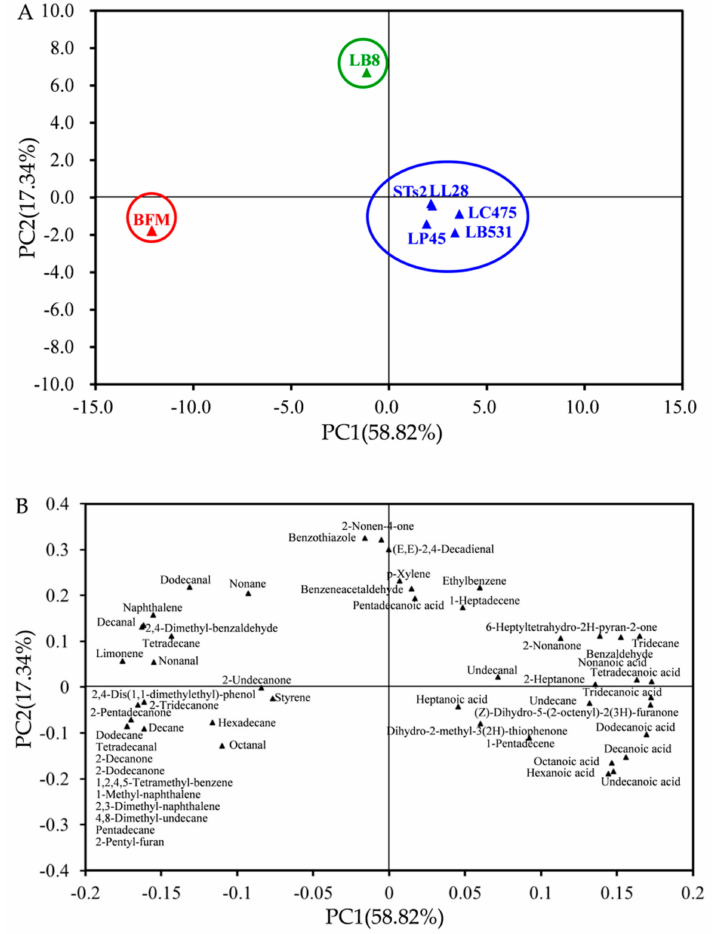
Figure 5. Principle component analysis (PCA) plots from ( A ) separation of milks fermented by di ff erent starter cultures based on the content. ( B ) Distribution of volatile compounds in milks fermented by di ff erent starter cultures based on